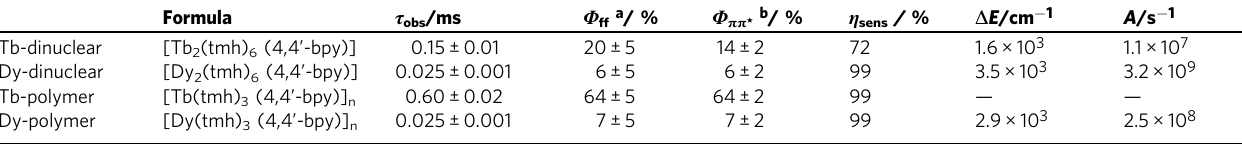
Table 1 Photophysical properties of the dinuclear complexes and coordination polymers under ambient conditions. Formula τ obs /ms